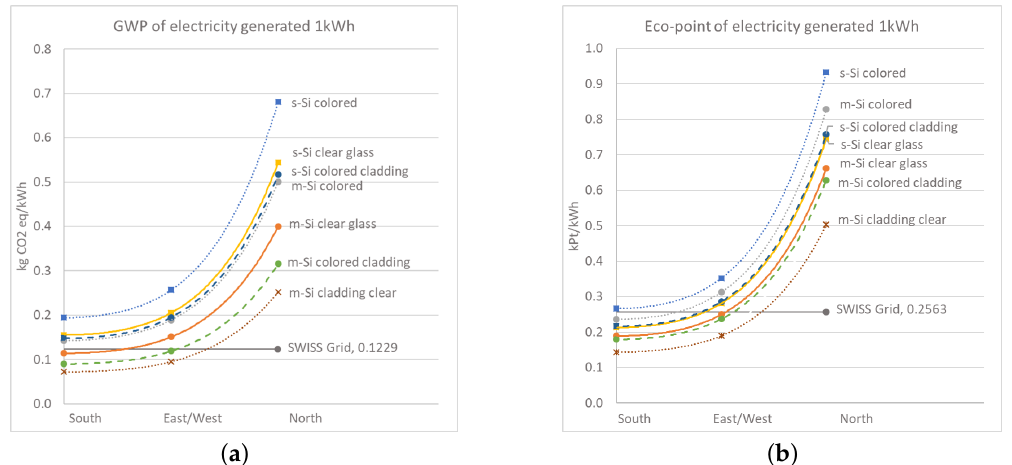
Figure 9. Environmental impact of 1 kWh of electricity generated from each configuration and orientation of the PV façade in terms of global warming potential (GWP) ( a ) and eco-points ( b